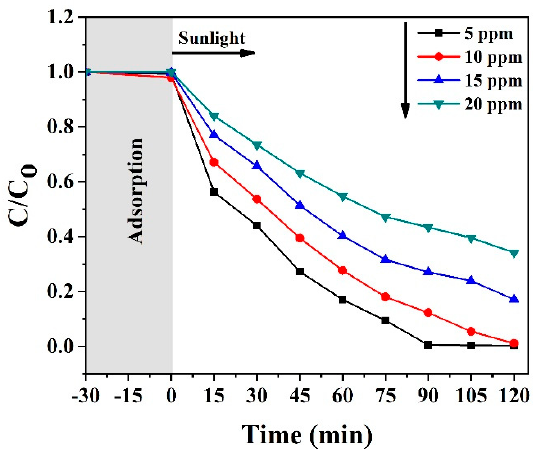
Figure 12. Photoreduction efficiency of nitrogen-annealed TNTs with EDTA and different Cr(VI) concentrations under natural sunlight for 120 min.